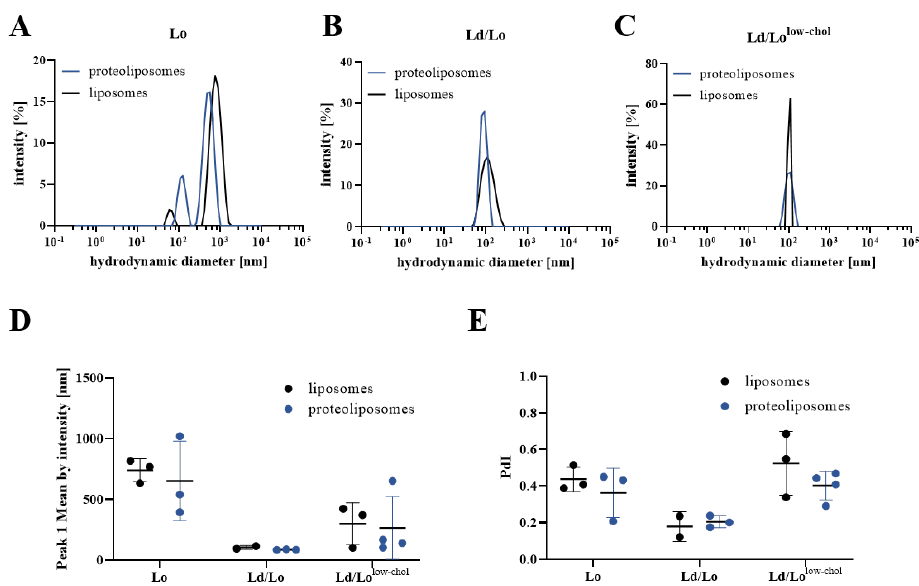
Figure 4. Intensity distribution of (proteo-)liposomes measured by DLS. Representative DLS data obtained at 37 °C show the scattering intensity of liposomes and proteoliposomes prepared with the dialysis protocol containing different DOPC:SM:cholesterol ratios ( A ) Lo, ( B ) Lo/Ld, and ( C ) Lo/Ld low-chol . ( D ) Peak 1 mean by intensity and ( E ) polydispersity indices (PdI) from (proteo)liposome DLS data of at least two independent measurements are shown in dot plots with Mean ± SD. Corresponding correlation functions are presented in Figure S4.